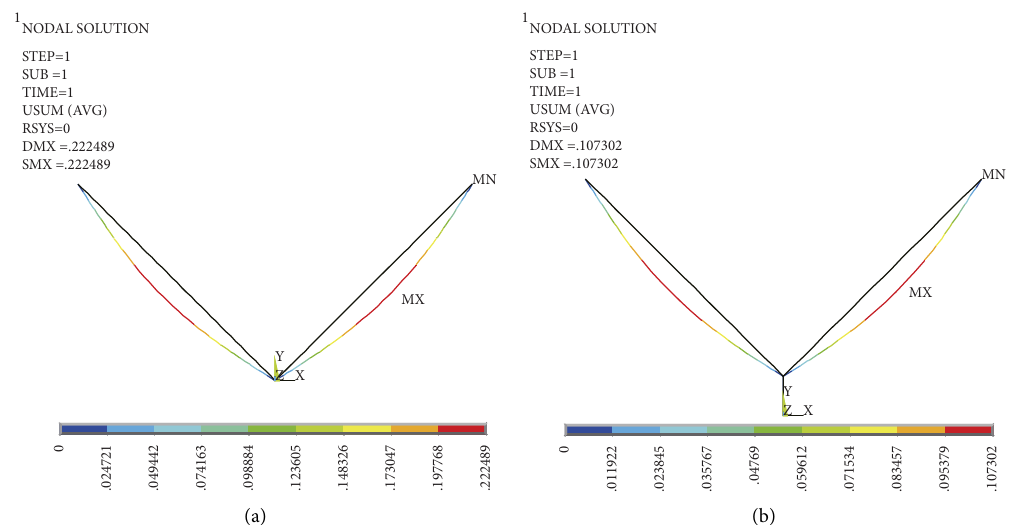
Figure 10: (a) Te gravity form-fnding of the V -type insulator string. (b) Te gravity form-fnding of the Y -type insulator string.